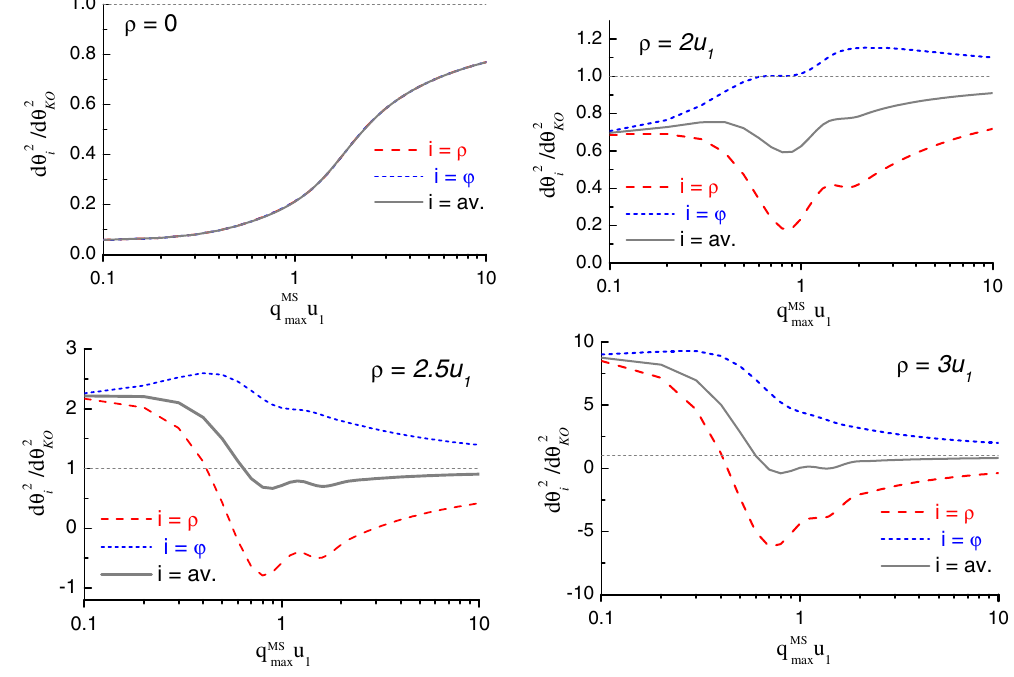
FIG. 6. Mean square angles of the scattering in both the radial ( i ¼ ρ ) and azimuthal ( i ¼ φ ) directions along with their average at ρ ¼ 0 (top left), ρ ¼ 2 u 1 (top right), ρ ¼ 2 . 5 u 1 (bottom left), and ( i ¼ av ) versus the maximum contributing momentum transfer q MS max ρ ¼ 3 u 1 (bottom right), plotted as a ratio to the analogous positive values, evaluated using the KO ansatz